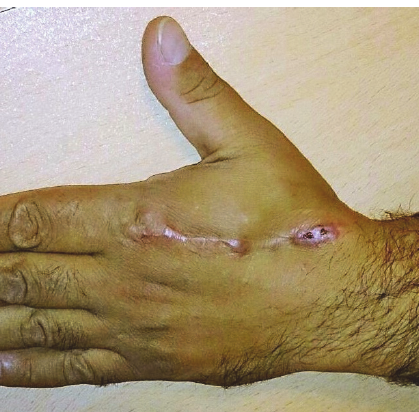
Figure 3: Sulfur granules were found at the center of the inflam- matory reactions as filamentous basophilic radiating fungal-like structures in the dermis (H&E ∗